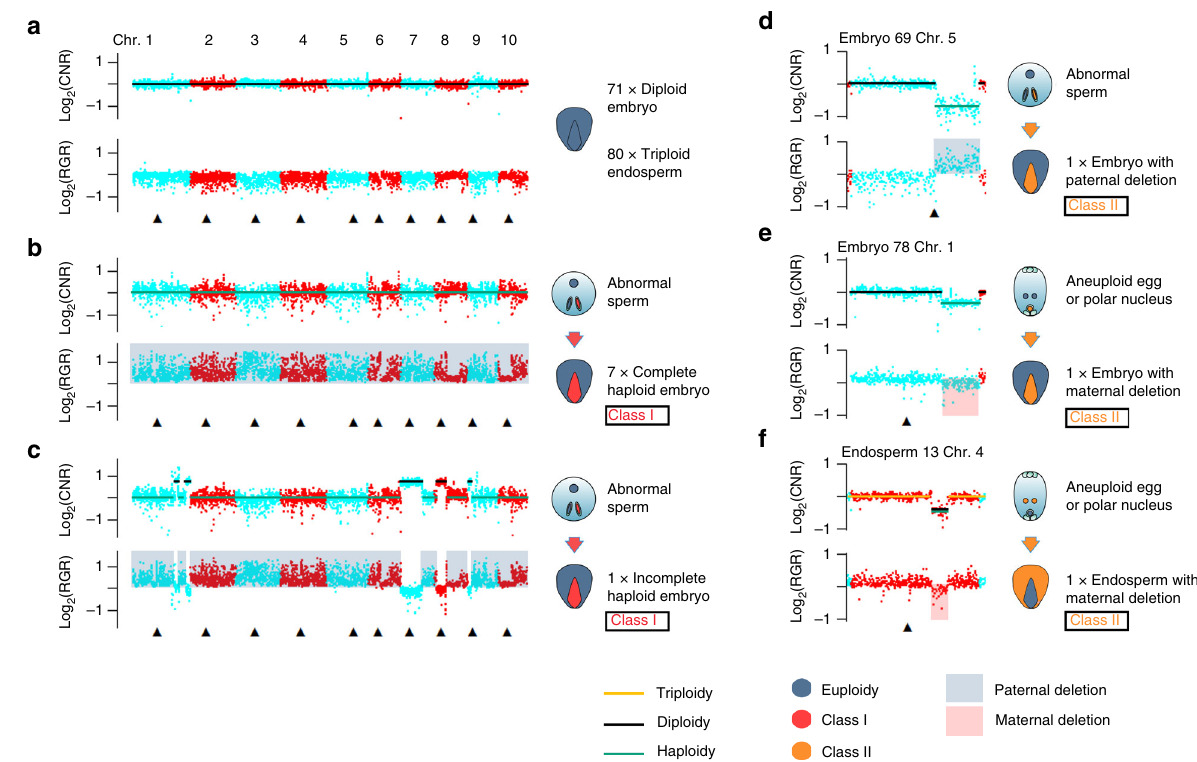
Fig. 4 Single embryo and endosperm sequencing reveals two classes of aneuploidy. In each panel, the upper dot plot represents CNV by the log 2 (CNR) value, CNV is identi fi ed if continuous and dispersed obviously Log 2 (CNR) values between large segments ( > 10 Mb) are observed. The lower dot plot represents the genetic background SNP-ratio by log 2 (RGR) value, which means paternal genome deletion if the value is > 0, in contrast, maternal genome deletion if the value is < 0. The upper and lower fi gure of each panel is referring to the same sample. a The normal euploid embryo (embryo 1). A total of 71 embryos and 80 endosperms were identi fi ed as euploid. b The complete haploid embryo (embryo 16), in which CAU5-derived chromosomes are eliminated. A total of seven (embryos 16, 19, 21, 32, 38, 45, and 73) were identi fi ed as haploid. c One incompletely haploid embryo (embryo 44), in which fragments of chromosomes 1, 7, 8, and 9 remain. d Chromosome 5 of one embryo (embryo 69), in which the CAU5-derived fragments were lost. e Chromosome 1 of one embryo (embryo 78), in which the Zheng58-derived fragments were lost. f Chromosome 4 of one endosperm (endosperm 13), in which the Zheng58-derived fragments were lost. The blue and red spots represent CNVs in odd and even chromosomes, respectively. The black triangles point to centromeres. In the CNV plots, the green, black, and yellow lines around spots indicate haploidy, diploidy, and triploidy, respectively. In the SNP-ratio plots, the blue and red shadings indicate paternal and maternal deletions,